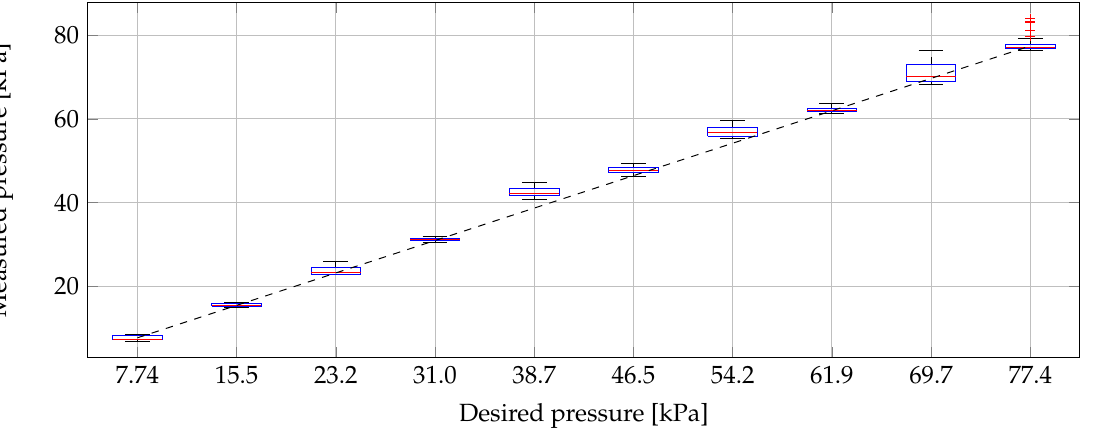
Figure 5. The actual measured pressure during the dielectric measurements of Experiment 5, graphically presented in a box plot, with respect to the desired pressure (dashed black line). (The horizontal red line indicates the median value and the blue box ranges from the 25th to the 75th percentile, respectively called Q 1 and Q 3 . The minimum and maximum values are indicated with the horizontal black lines × (Q + 3 × (Q except if they are smaller than Q 1 − 3 3 – Q 1 ) or larger than Q 3 3 – Q 1 ). In that case, they 2 2 are represented with a red